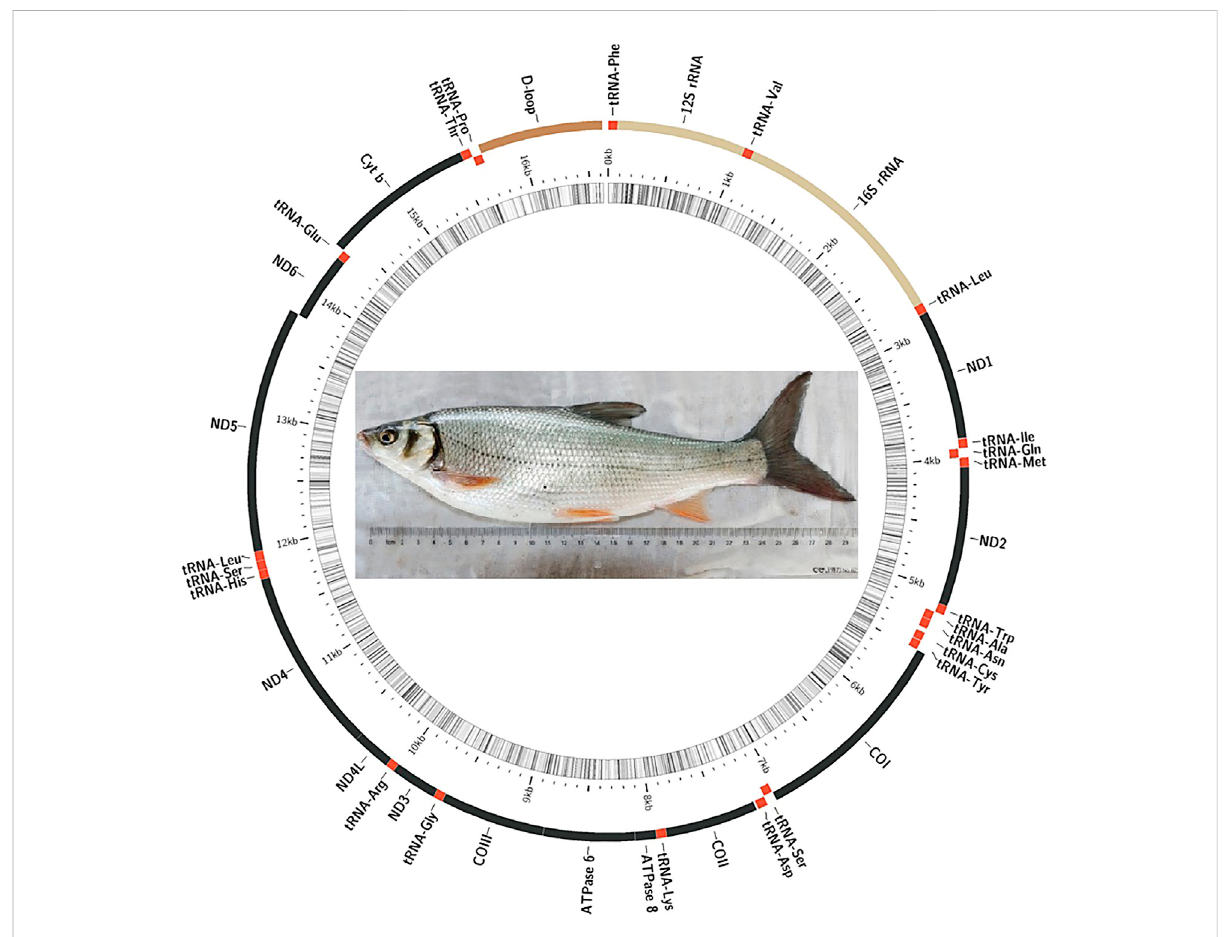
FIGURE 1 Mitogenomic map of the mitogenomes of Xenocyprinae